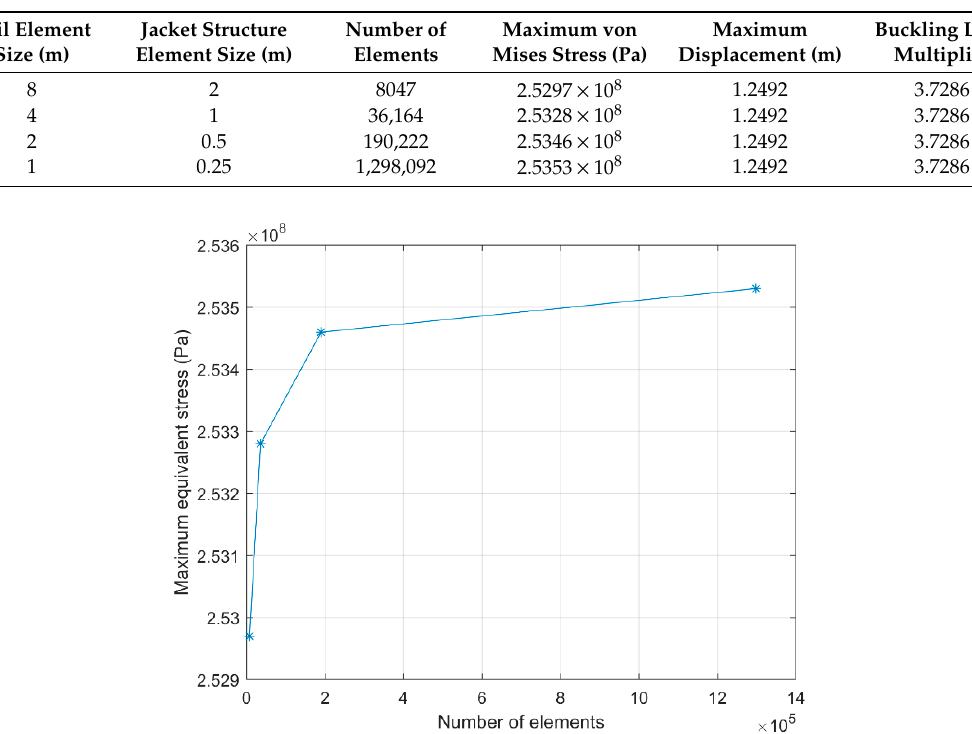
Table 4. Mesh sensitivity.